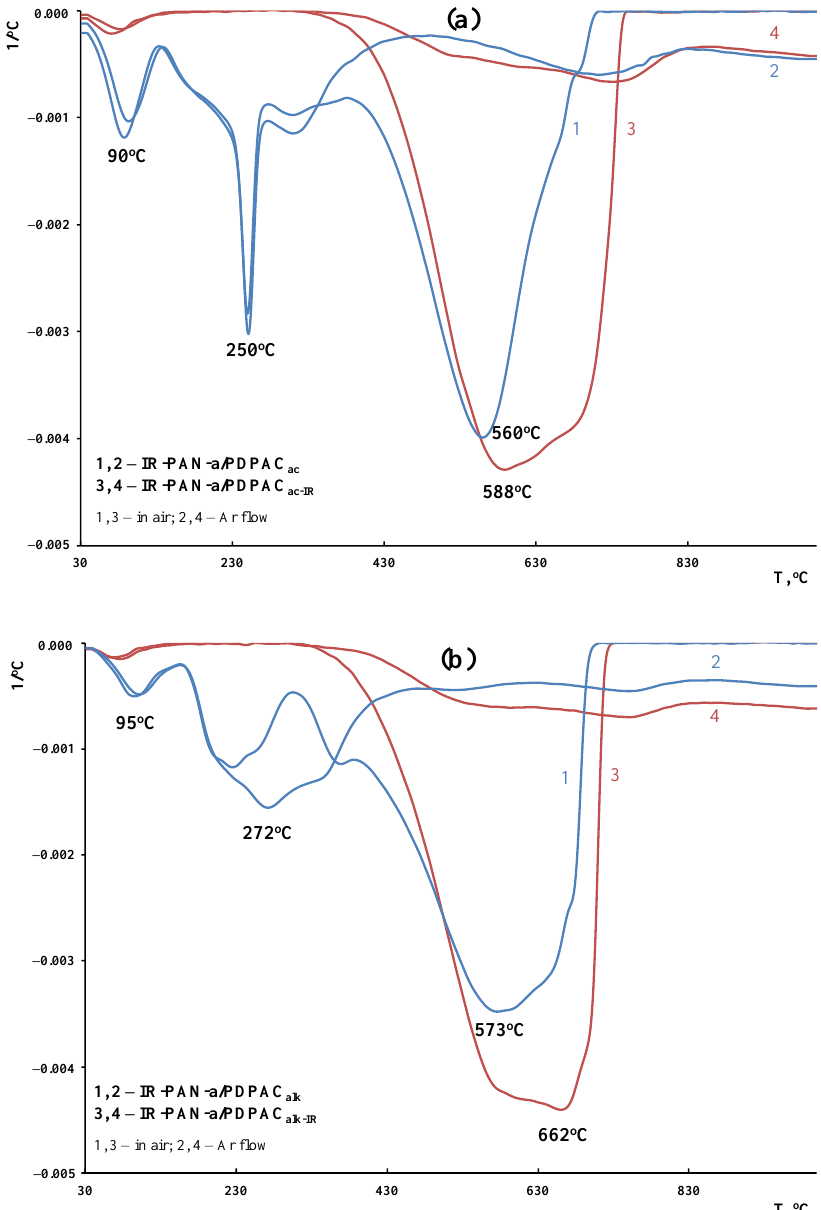
Figure 14. DTG curves of IR-PAN-a/PDPAC (1, 2) and IR-PAN-a/PDPAC IR (3, 4) prepared in an acidic ( a ) and an alkaline medium ( b ), in the Ar flow (1, 3) and in the air (2, 4).